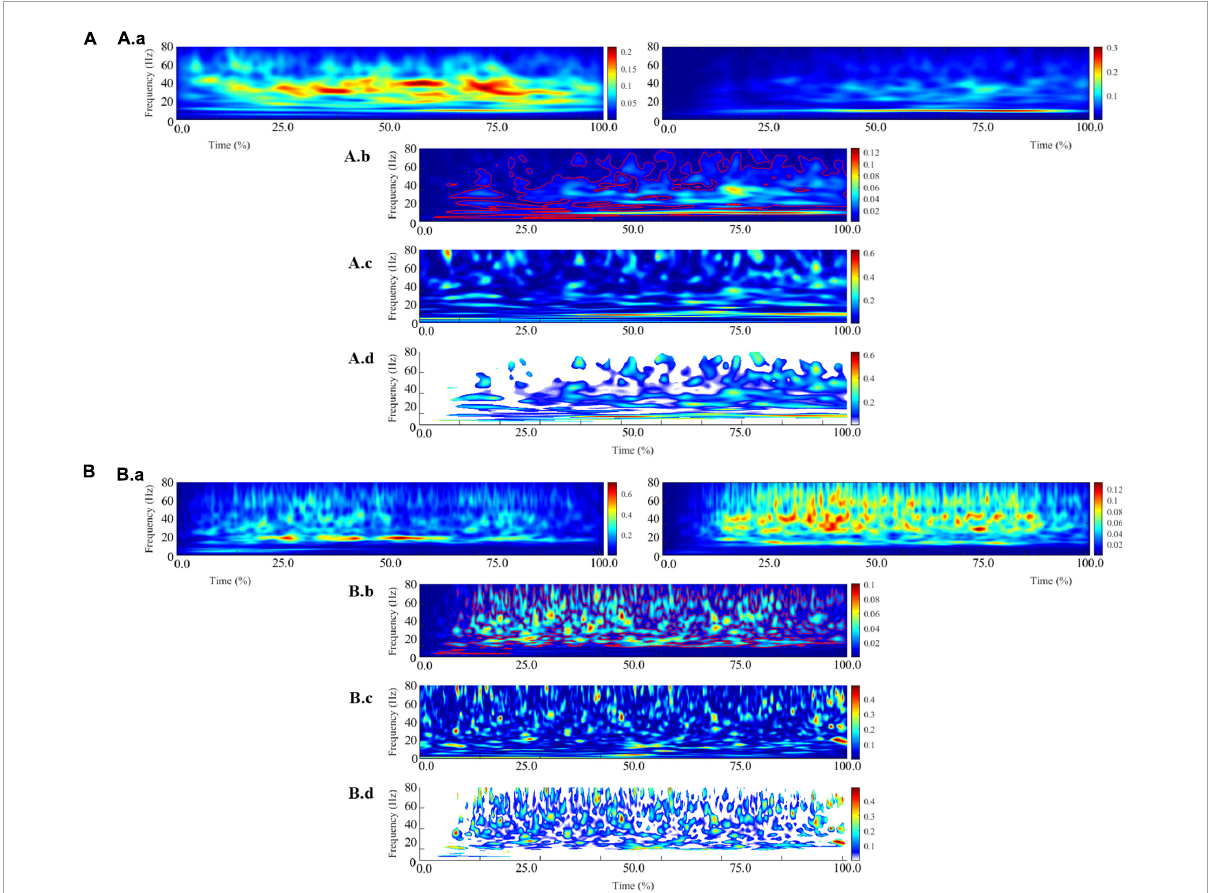
FIGURE3 Illustration of the different steps involved in calculating intermuscular coherence for a typical control subject (A) and a typical stroke subject (B) . The (A.a, B.a) panels represent the average of the auto-spectrum calculated for each movement from the biceps brachii (left) and brachioradialis (right) electromyographic signals. These panels represent the frequential properties of the respective muscular signals. The panels (A.b, B.b) panels represent the cross-spectrum, and the red contours identify areas in the time-frequency plane where correlations between the electromyographic signals are significant. The (A.c, B.c) panels represent the wavelet magnitude-squared coherence between the two electromyographic time series. The (A.d, B.d) panels represent the wavelet magnitude-squared coherence where the correlation between the EMG signals is